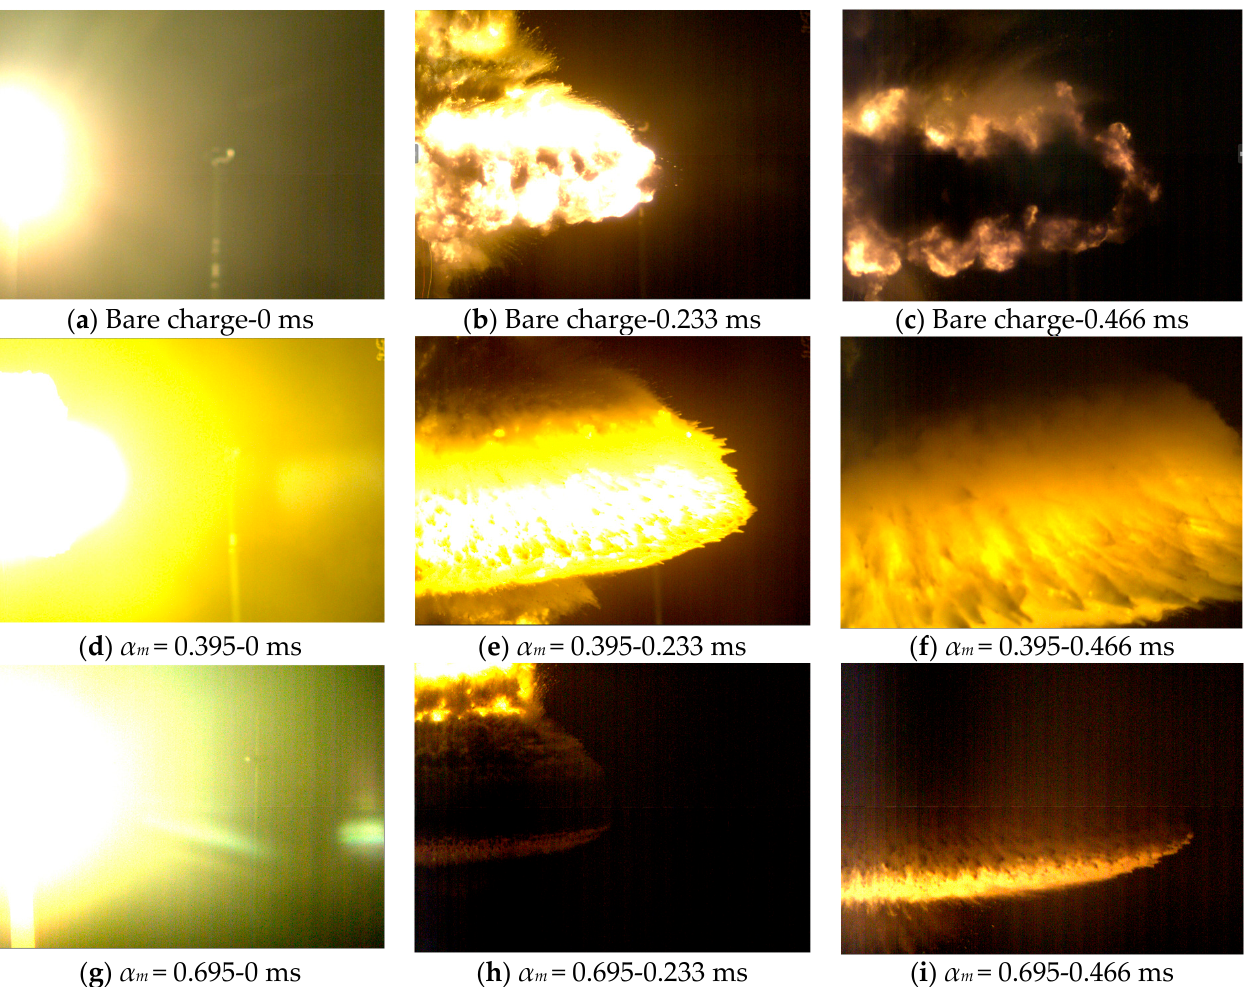
Figure 3. Typical explosion images of a charge enveloped by a non-metallic shell.